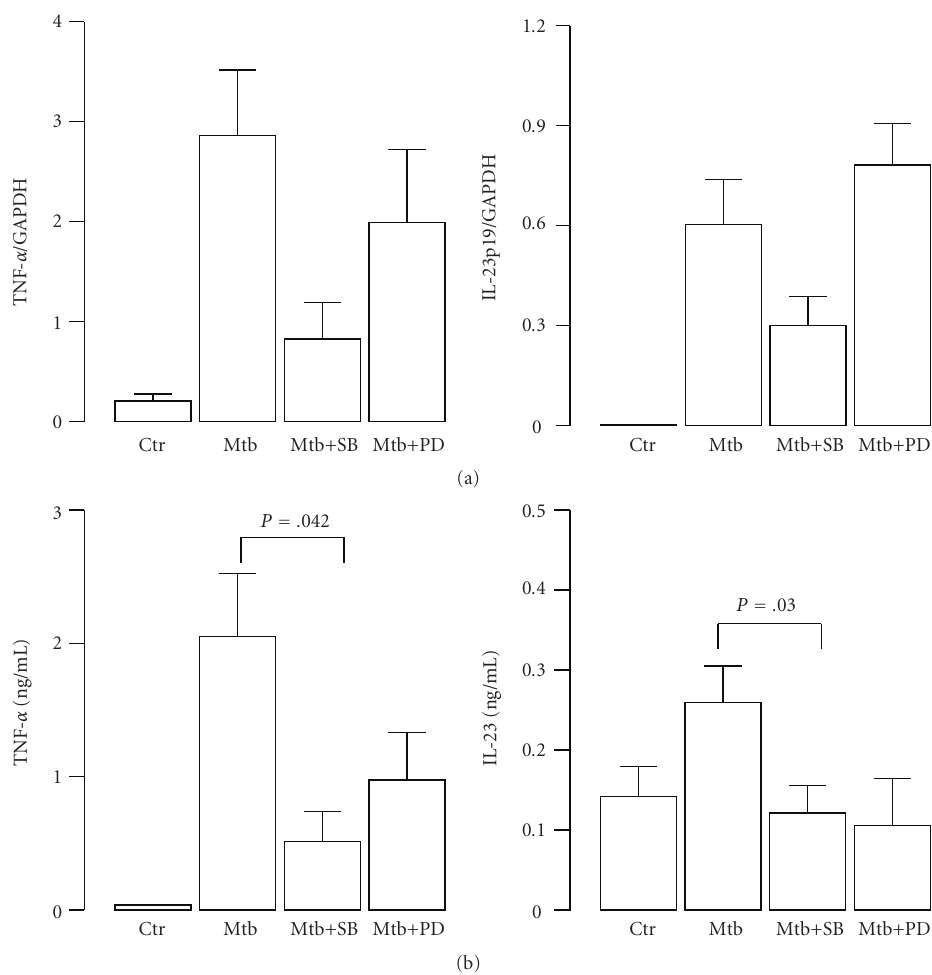
Figure 4: Regulation of IL-23 expression by MAPK in Mtb-infected human monocytes. Monocytes were pretreated or not with p38 (SB203580) or ERK (PD98059) inhibitors for 30 min and afterwards were infected with Mtb as indicated. (a) After 8hr, RNA was extracted and real-time RT-PCR was performed to measure the expression of TNF- α and IL-23p19 subunit transcripts. The results shown are from one out of three experiments performed with di ff erent donors that yielded similar results. (b) After 24hr, the cell culture supernatants were collected, and the production of TNF- α and IL-23 was measured by CBA or ELISA assay. The results represent the mean ± SE of four independent